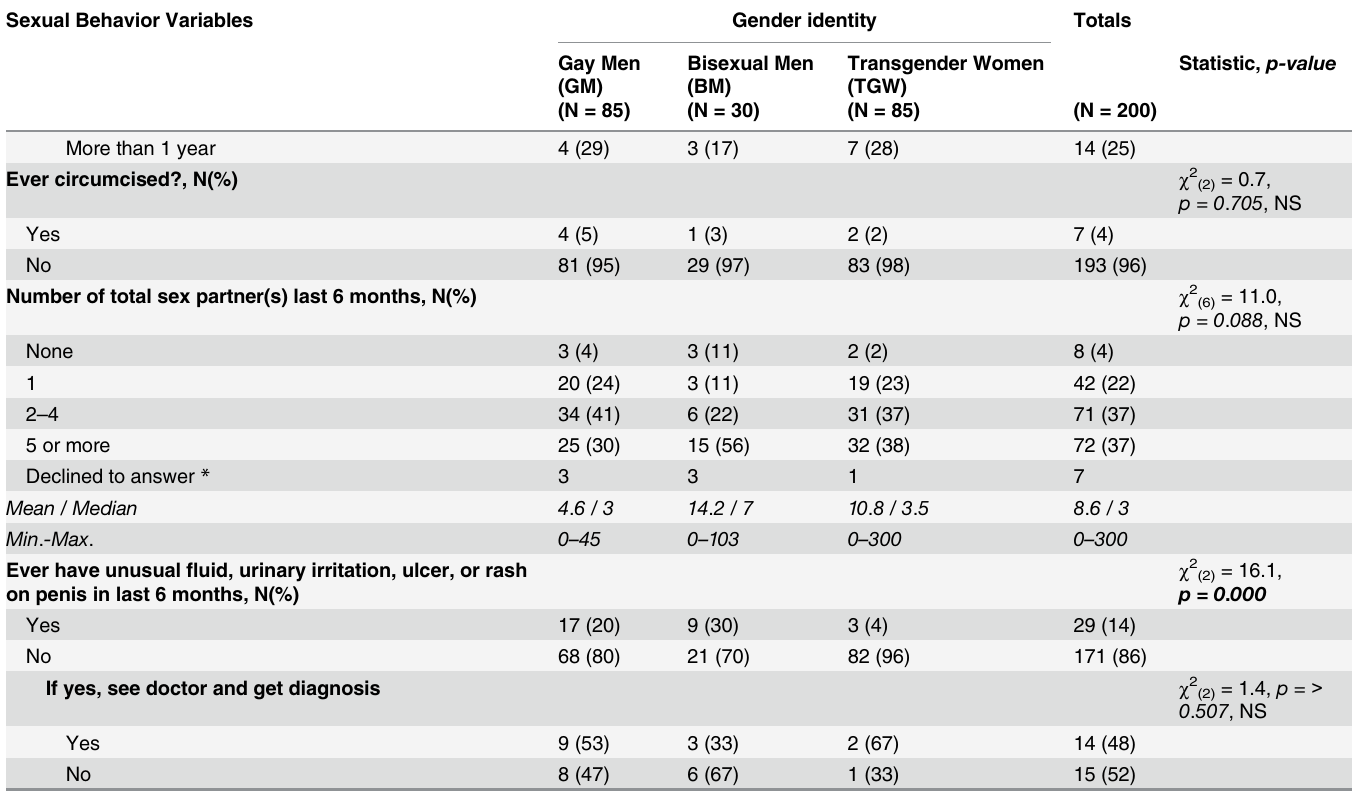
for sex more often than GM or TGW (p < 0.0001). TGW reported lower frequency than GM and BM of penile symptoms suggestive of STIs (p < 0.001).